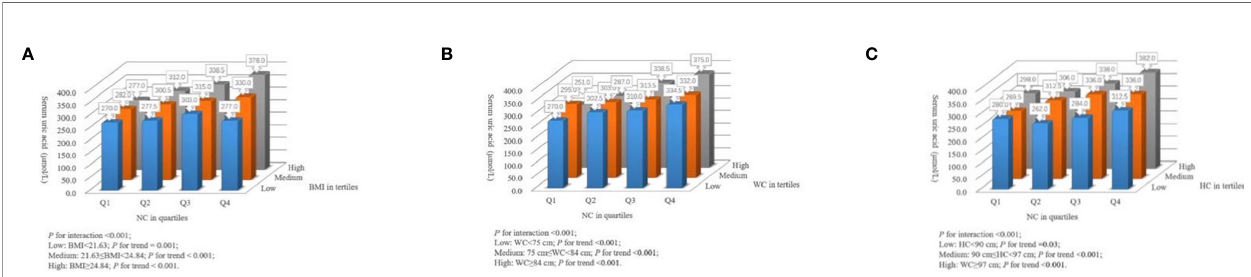
FIGURE 1 | Interactions of NC with other anthropometric measurements in serum uric acid level. (A) The joint effect of NC (in quartiles) with BMI (low, medium, and high levels) on serum uric acid level. (B) The joint effect of NC (in quartiles) with WC (low, medium, and high levels) on serum uric acid level. (C) The joint effect of NC (in quartiles) with HC (low, medium, and high levels) on serum uric acid level. NC, neck circumference; BMI, body mass index; WC, waist circumference; HC, hip circumference.